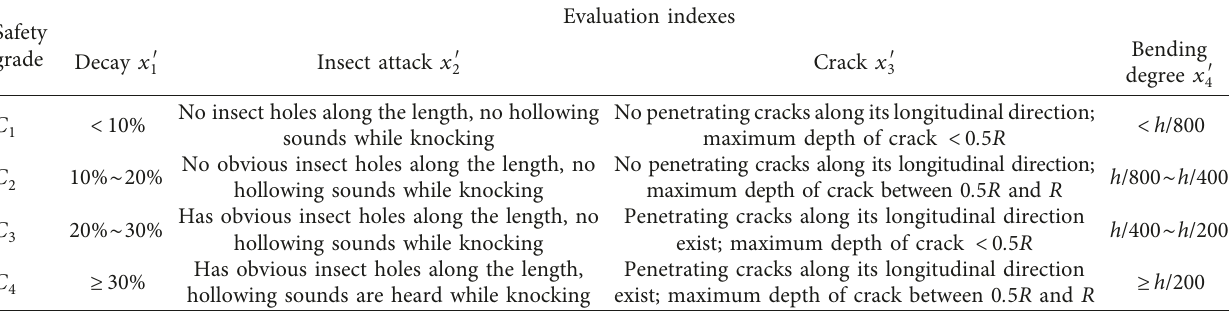
Table 3: Safety grade classification for wood